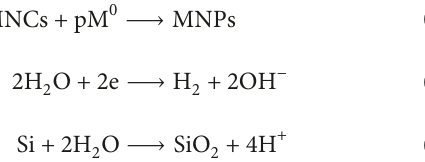
Figure 1: SEM images of PdNPs on the silicon surface obtained by electrolysis in a solution of 4 mM Pd(NO with DMSO for 400 cycles at E cathode (V): − 1.8 (a), − 2.0 (b), − 2.2 (c), and EDX-spectrum